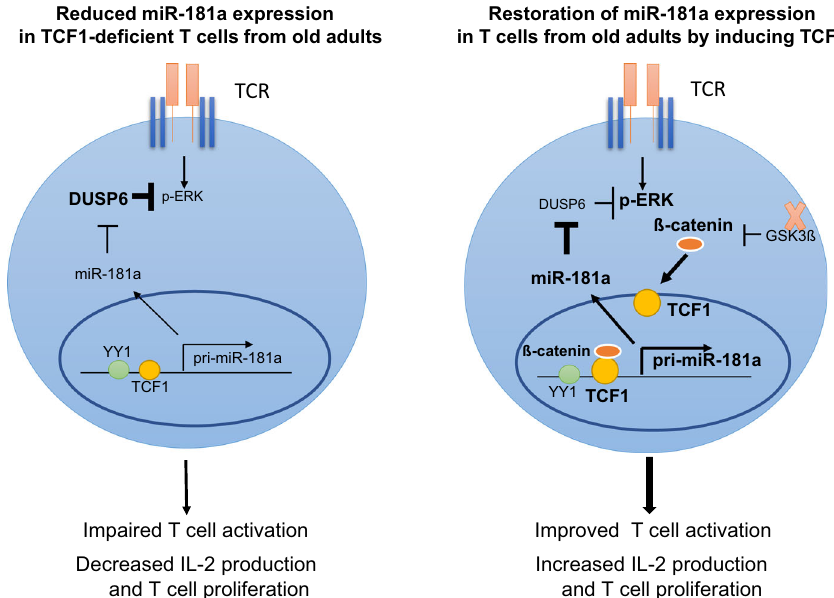
Fig. 5 Model of TCF1-mediated regulation of miR-181a dependent on GSK3ß. T cell aging is associated with a loss of miR-181a expression due to reduced TCF1 expression (left). Reduced miR-181a expression contributes to impaired T cell function by activating negative regulatory signaling pathways by miR-181a targets, e.g., ERK dephosphorylation by DUSP6. Inhibition of GSK3ß increases the expression of TCF1 and its target miR-181a in T cells from old adults, thus enhancing downstream T cell activation and proliferation